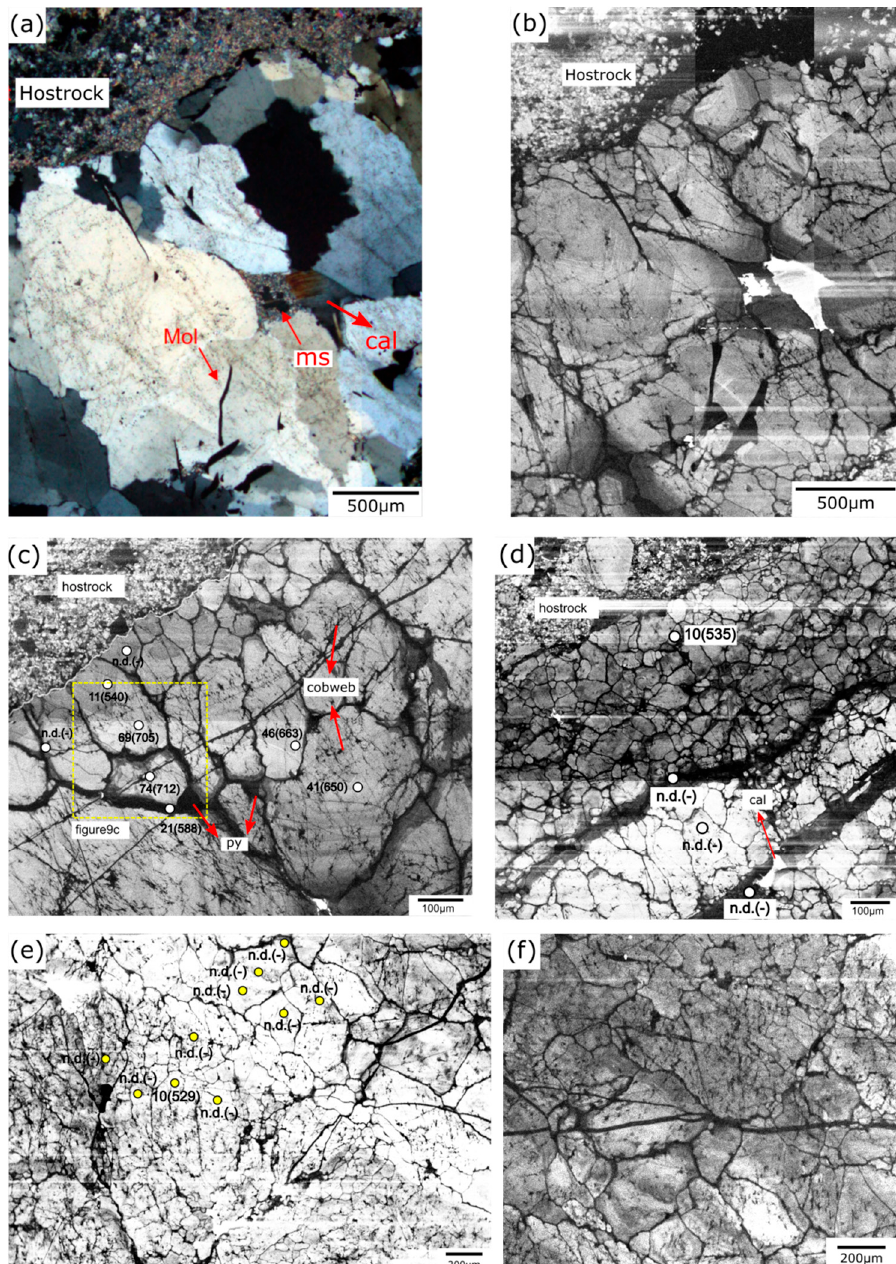
Figure 5. Images of veins. ( a ) Crystallographic orientation in cross-polarized light of the qtz–mol vein. ( b ) SEM–cathodoluminescence (CL) image of the qtz–mol vein shown in ( a ). ( c , d ) SEM–CL images of the qtz–py veins showing Ti analyses and temperatures. ( e , f ) SEM–CL images of the qtz veins showing Ti analyses and temperatures.